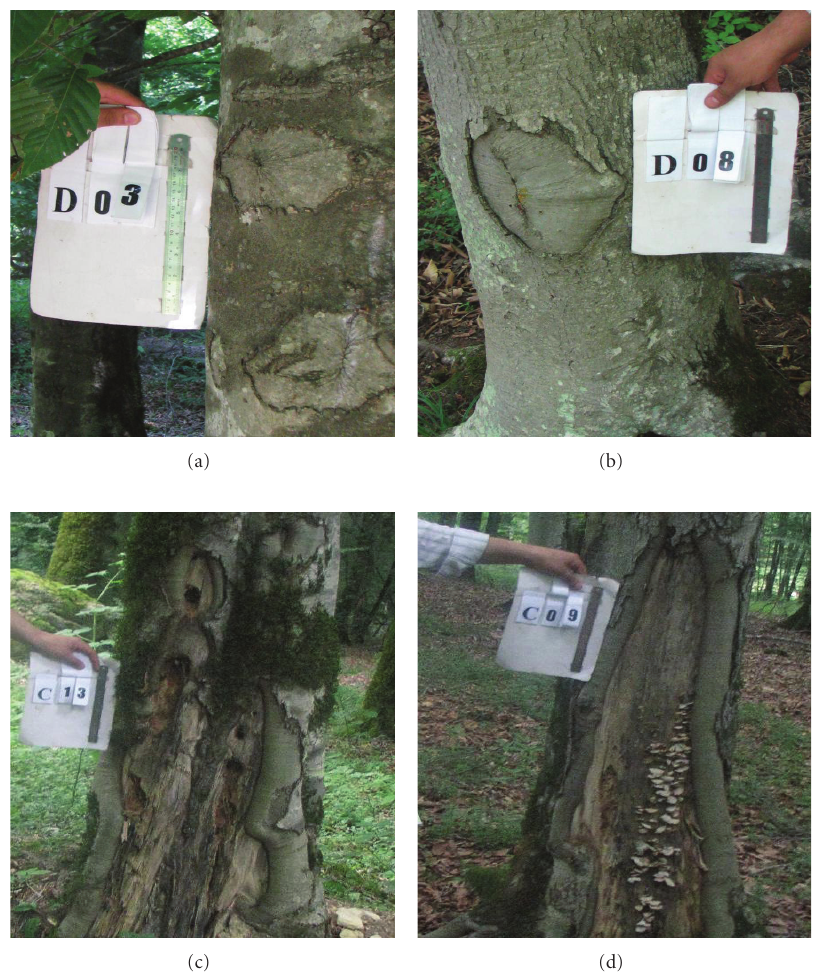
Figure 3: The view of stand damages due to timber skidding in low (a), (b) and high (c), (d) tra ffi c